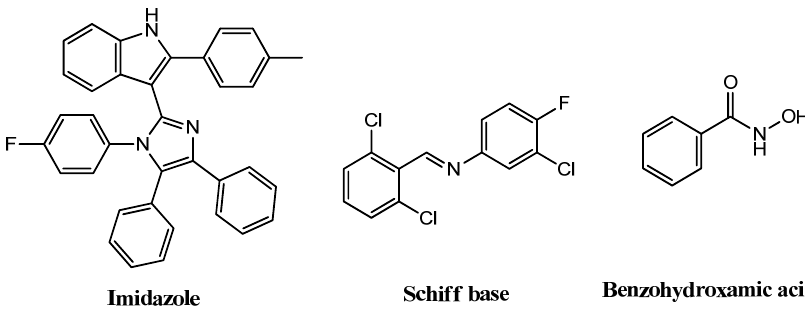
Figure 1. Previously reported urease inhibitors.